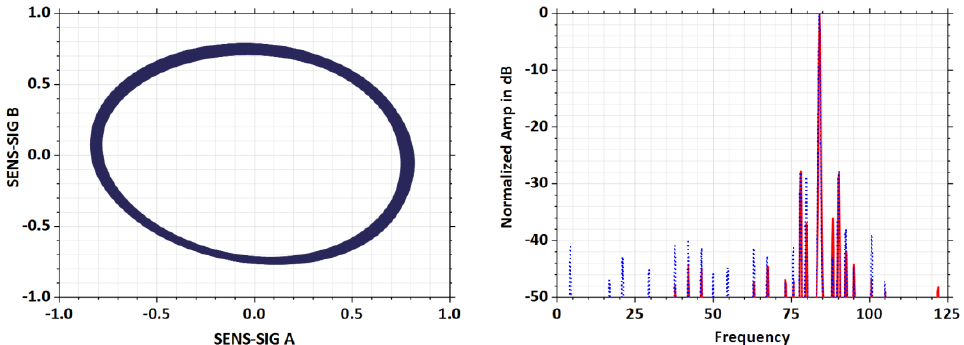
Figure 25. Outputs of a rotor R1 (no defect).